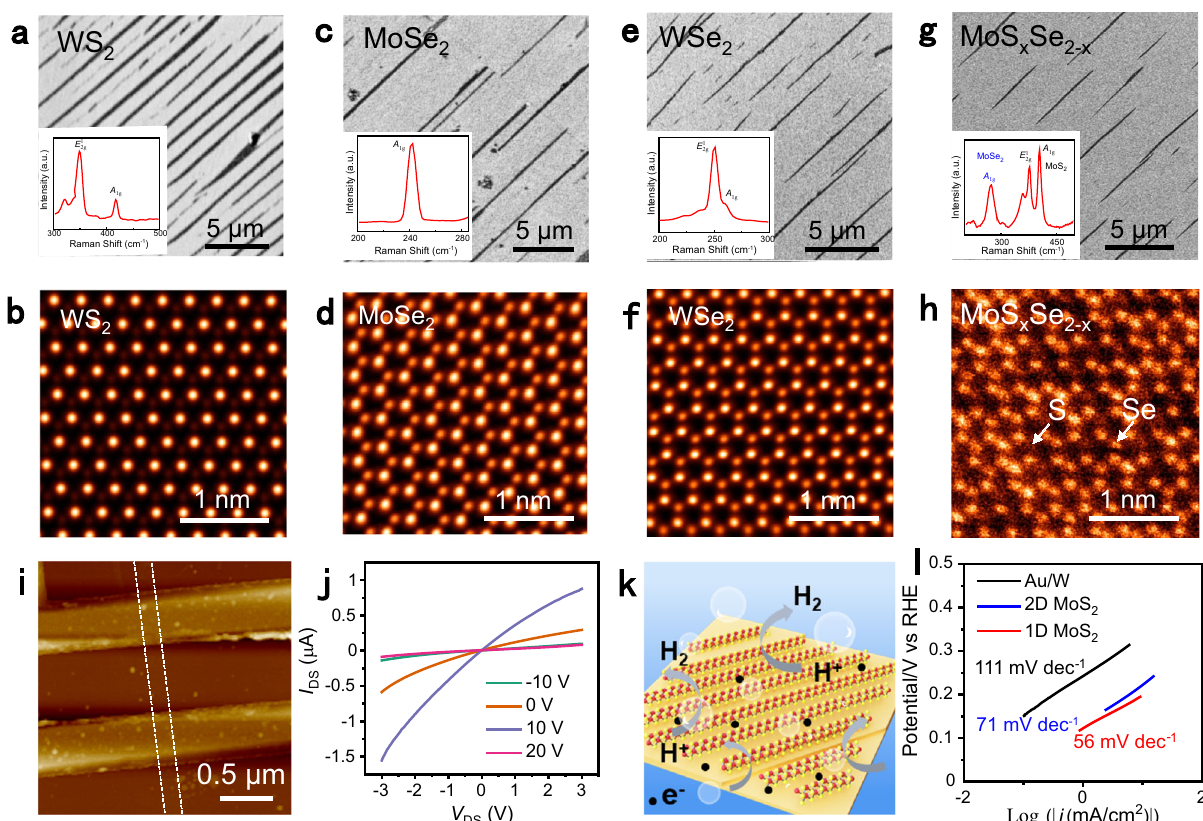
Fig. 6 Au-step-edge-directed growth of other monolayer TMDs ribbons. a , b . SEM image ( a ), representative Raman spectrum (inset of ( a )), and STEM image ( b ) of as-grown monolayer WS 2 ribbon arrays. c , d SEM image ( c ), representative Raman spectrum (inset of ( c )), and STEM image ( d ) of as-grown MoSe 2 ribbon arrays. e , f . SEM image ( e ), representative Raman spectrum (inset of ( e )), and STEM image ( f ) of as-grown monolayer WSe 2 ribbon arrays. g , h SEM image ( g ), representative Raman spectrum (inset of ( g )), and STEM image ( h ) of as-grown monolayer MoS x Se 2-x ribbon arrays. i AFM image of a representative monolayer MoS 2 ribbon-based device with a width of ~110 nm. j Output characteristics of the monolayer MoS 2 ribbon-based device. k Schematic illustration of the HER process. Red and yellow spheres represent Mo and S atoms, respectively, and the black dots denote the electric charges. l Tafel plots of the as-grown monolayer MoS 2 triangles and monolayer MoS 2 ribbons on Au/W